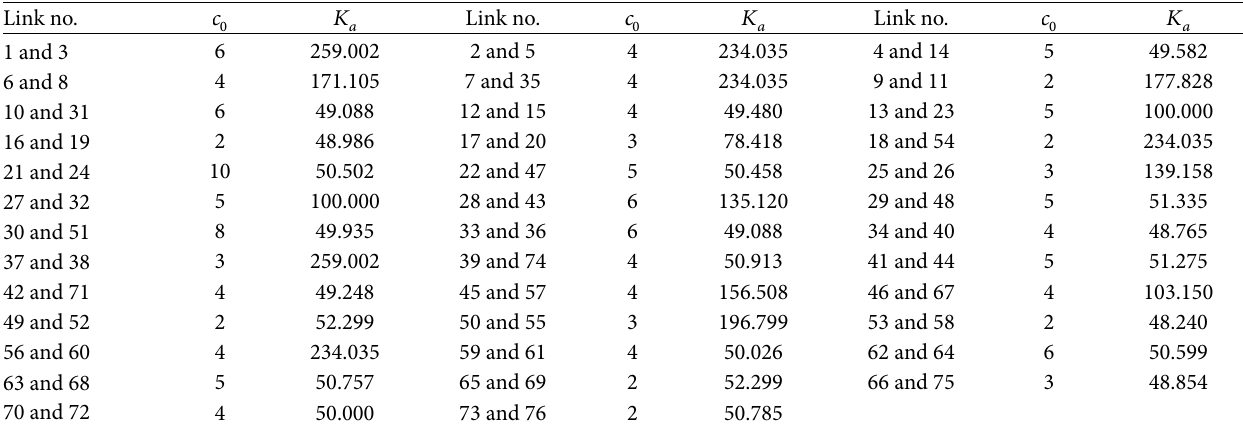
Figure 1: Test transportation network. Table 3: Parameters of link travel time